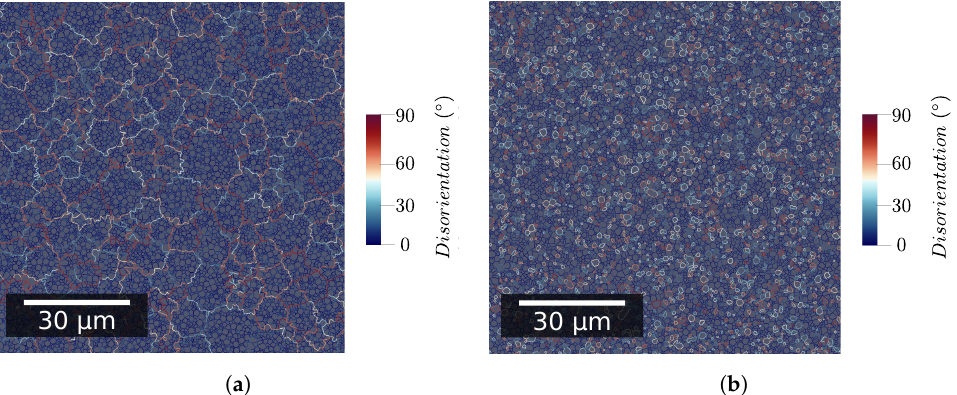
Figure 2. Initial GB network with color code corresponding to GB disorientation. ( a ) Standard grain/subgrain topology; ( b ) No grain/subgrain